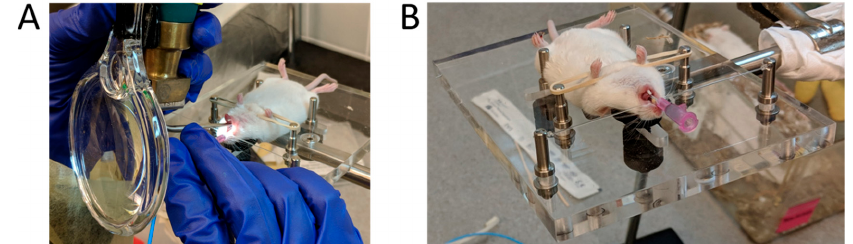
Figure 3. Mouse intubation using the BioLite Intubation System (Braintree Scientific Ltd., Braintree,